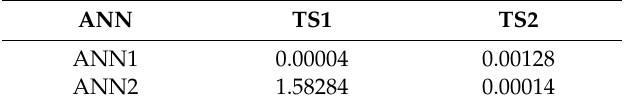
Table 1. Classical ANOVA F-test results obtained for F y* values.